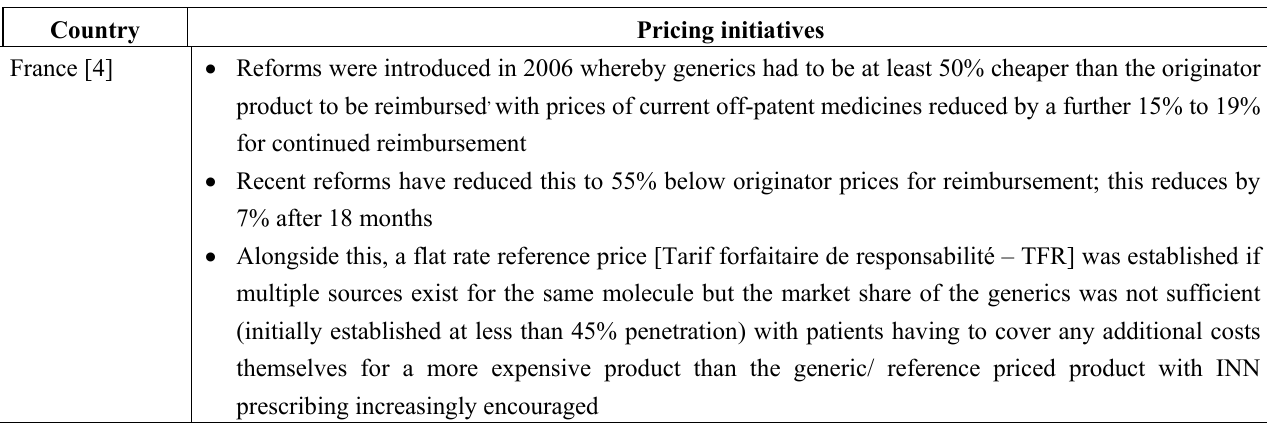
Table A2. Prescriptive pricing approaches for generics in selected European